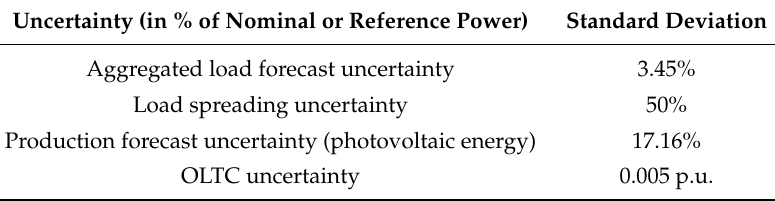
Table 1. Uncertainties standard